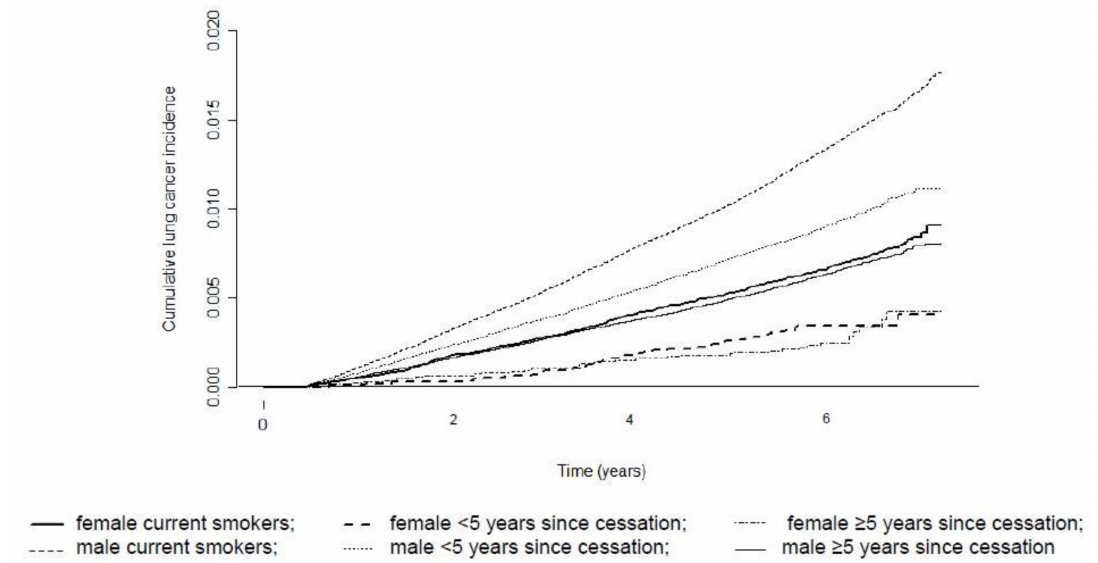
Figure 3. Cumulative lung cancer incidence according to years since cessation in former smokers compared with cur- rent